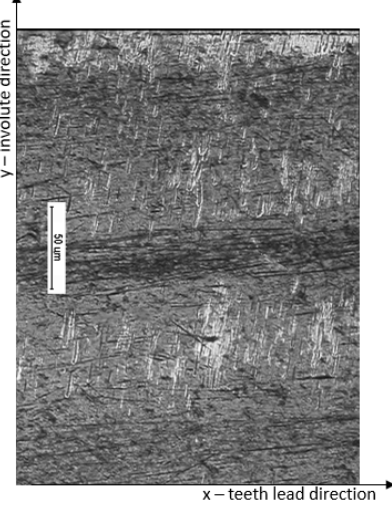
Figure 9. Non-preferable teeth flanks wear in high waviness peaks.